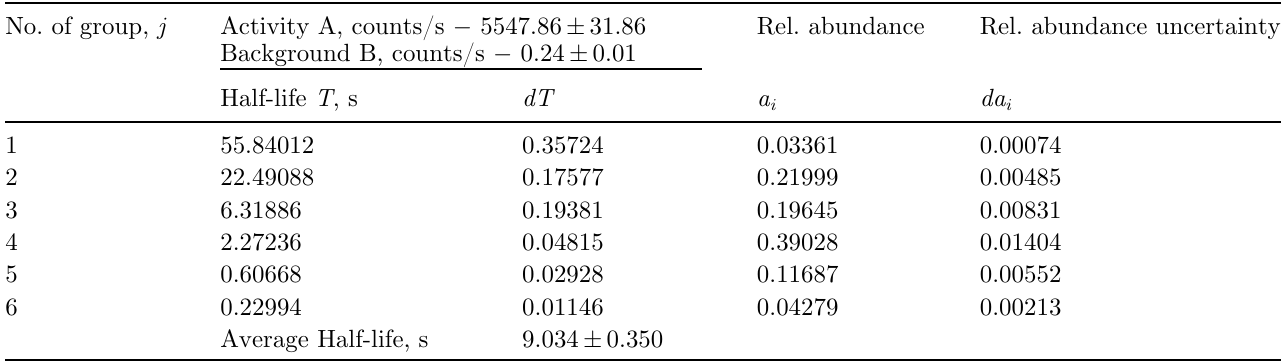
Table 9. The 6-group DN parameters ( a the help of the 6-group DN parameters estimated on the basis of experimental decay curve.